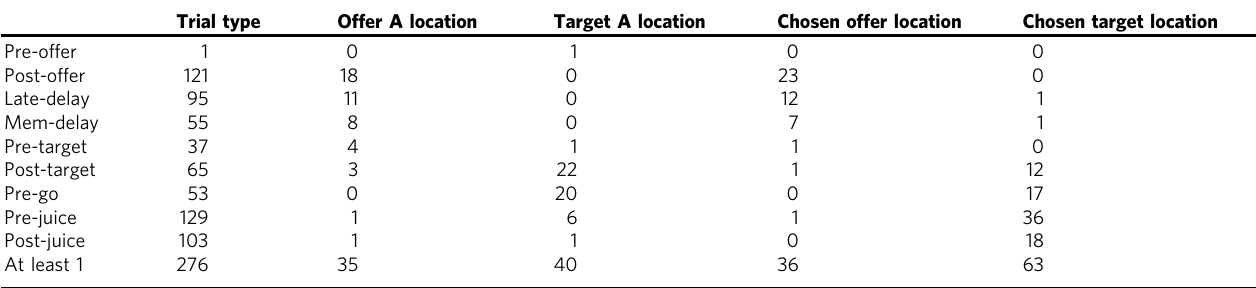
Table 1 Task-related responses in different time windows